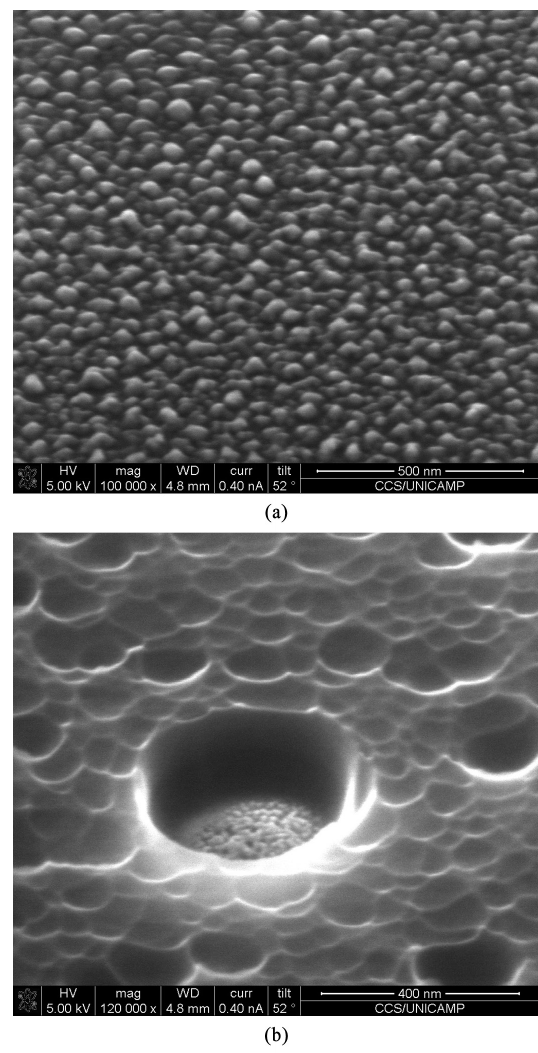
Figure 3. SEM images of structures grown at 34 mTorr C 3 nm Ni (a) and Cu (b) catalytic films.(Samples 34Ni and